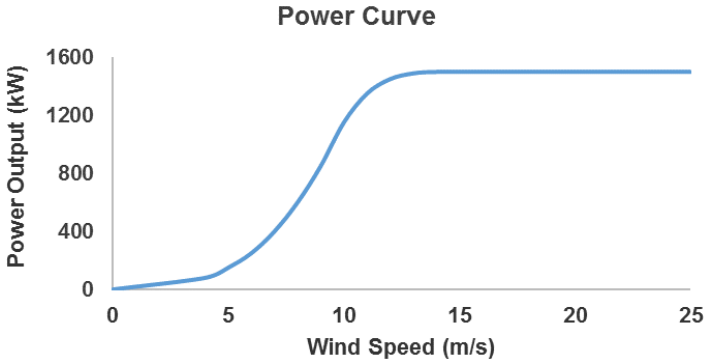
Figure 6. Power curve of 1.5 MW wind turbine.